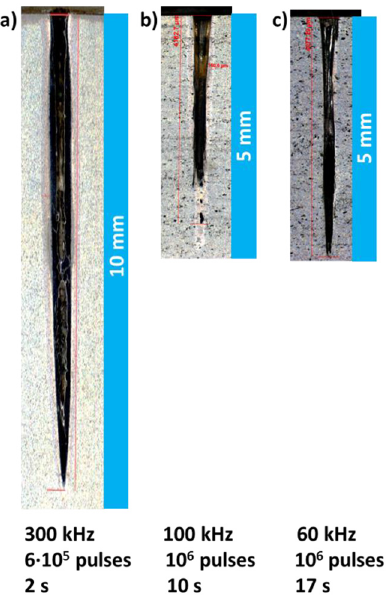
Fig. 6. Cross-sections of laser-drilled microholes with a pulse energy of 2.2mJ. All samples were etched with Nital 5% for 40 seconds.